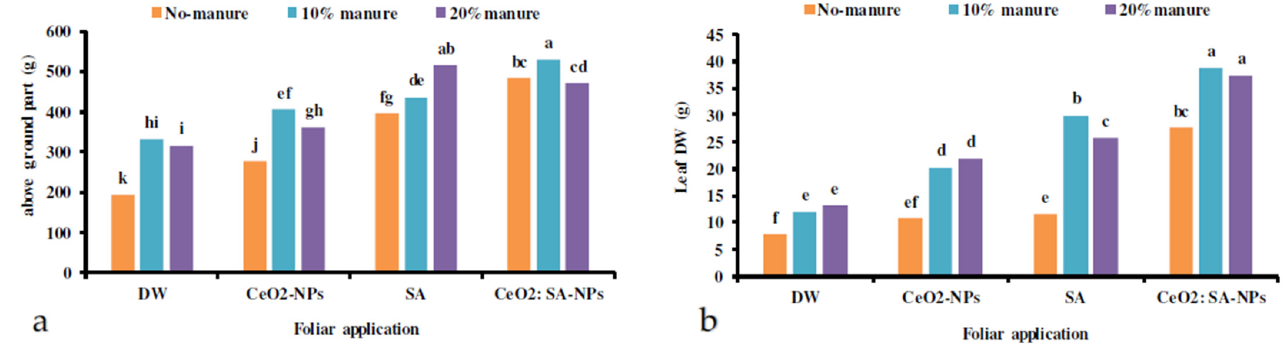
Figure 2. The interaction effects of animal manure application (no-manure, 10%, and 20% v / v ) and foliar spray of distilled water (DW), salicylic acid (SA), cerium oxide nanoparticles (CeO 2 -NPs), and cerium oxide salicylic acid nanoparticles (CeO 2 : SA-NPs) on the above-ground parts ( a ) and leaf dry weight ( b ) of Aloe vera L. plants. Significant differences among treatments are indicated by the different Latin letters.